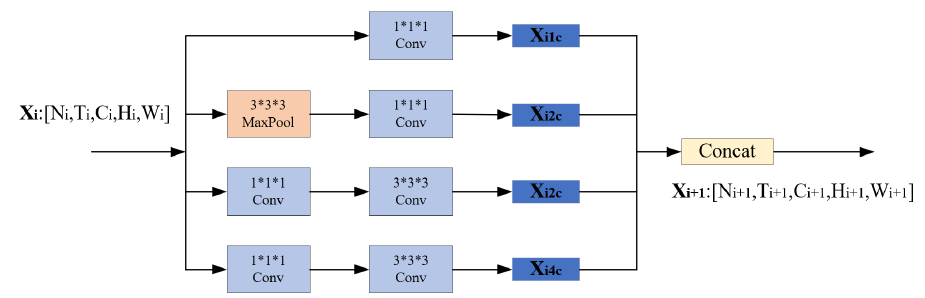
Figure 5. The basic module structure of